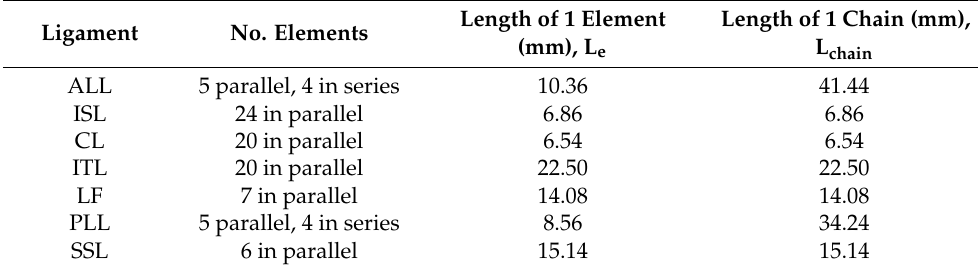
Table A1. Nonlinear force-stiffness characteristics of the ligaments.